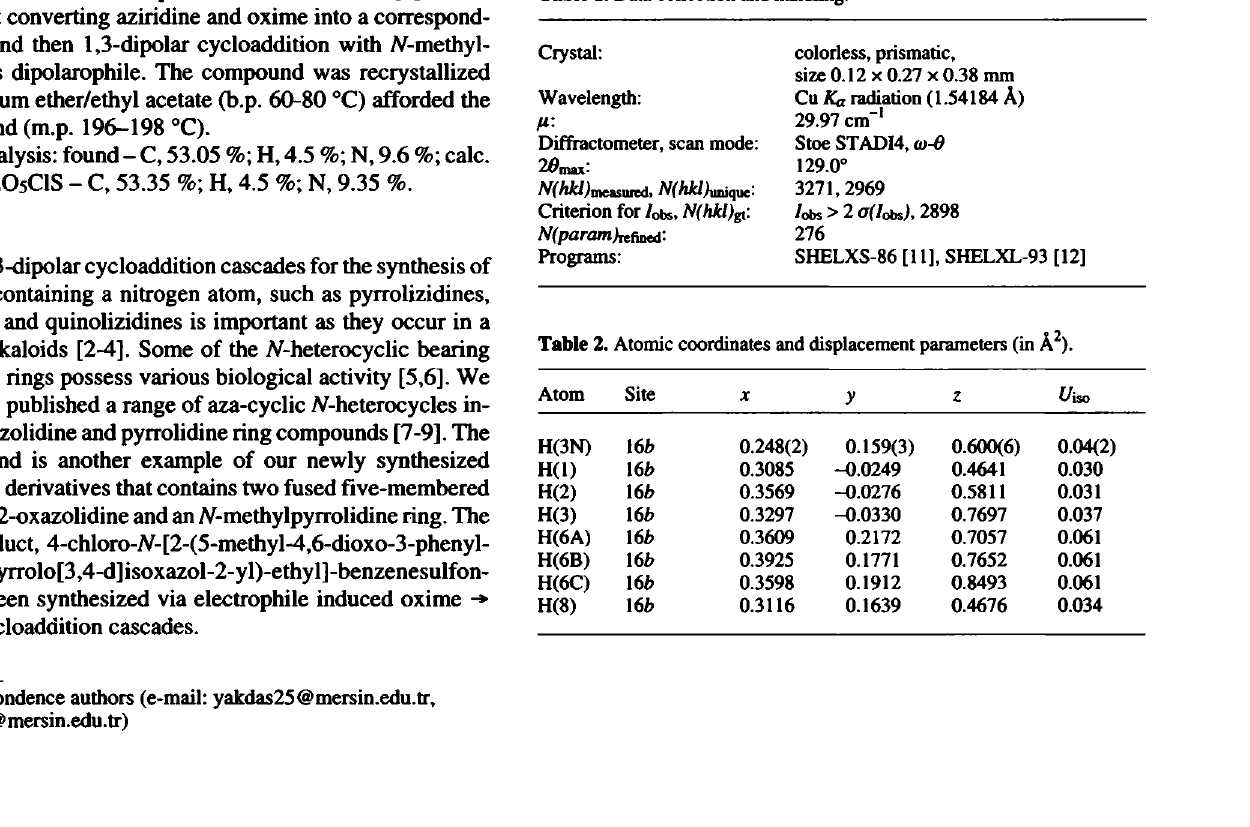
Table 1. Data collection and handling.